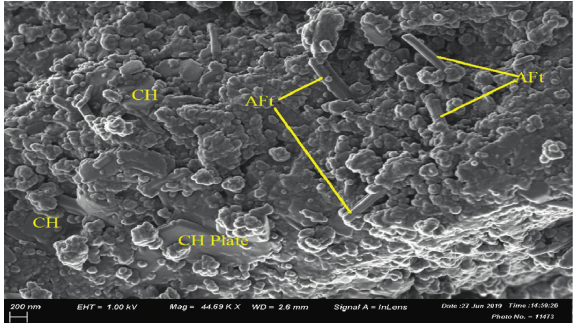
Figure 2: SEM image (ii) OPC (AT).